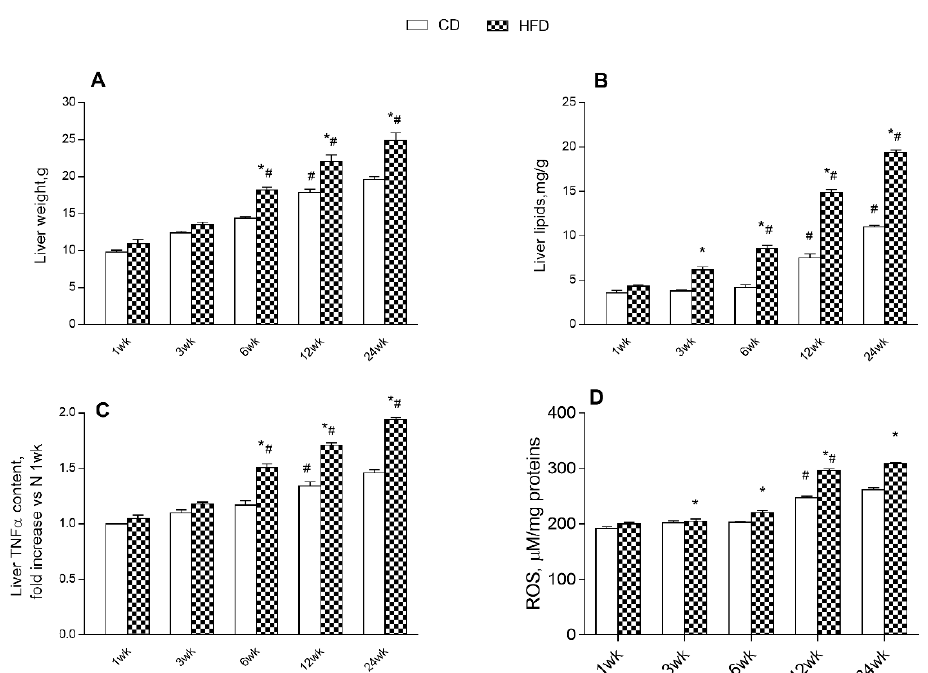
Figure 5. Effects of high-fat diet and aging on liver parameters. All the parameters were measured throughout the experimental period (1–24 weeks): ( A ) liver weight; ( B ) liver lipids, ( C ) tumor necrosis factors- α (TNF- α ), and ( D ) ROS content are shown. Data are indicated as means ± SEM from n = 6 animals/group. # Significantly different compared to previous time point, p < 0.05; * significantly different compared to CD group, p < 0.05.